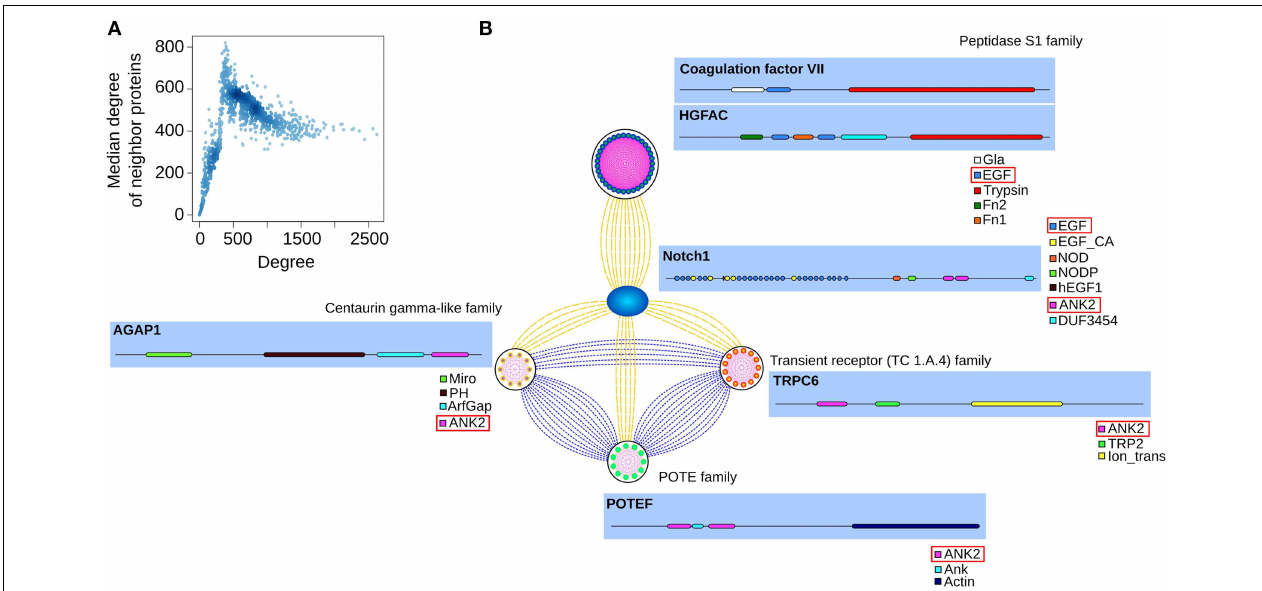
FIGURE 1 | (A) Nodes with up to ∼ 500 connections are neighbors of proteins with approximately the same degree. After the peak, nodes with higher degrees are connected to other nodes with ∼ 400 connections. Darker tones of blue indicate a higher concentration of nodes with these degree values. (B) Depicted are a few neighbors of notch1, their families, and domain compositions (with the shared domains boxed red). In the PSIN, notch1 is connected to members of the Peptidase S1 family through their shared EGF domain. The proteins from the other three families are connected to each other and to notch1 by their ankyrin